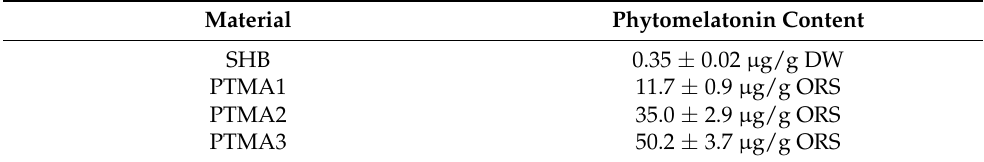
Table 2. Phytomelatonin analysis of selected herbs (SHB) and the final concentrated products (PTMAs) ( ± standard errors of the mean of four replicate experiments).